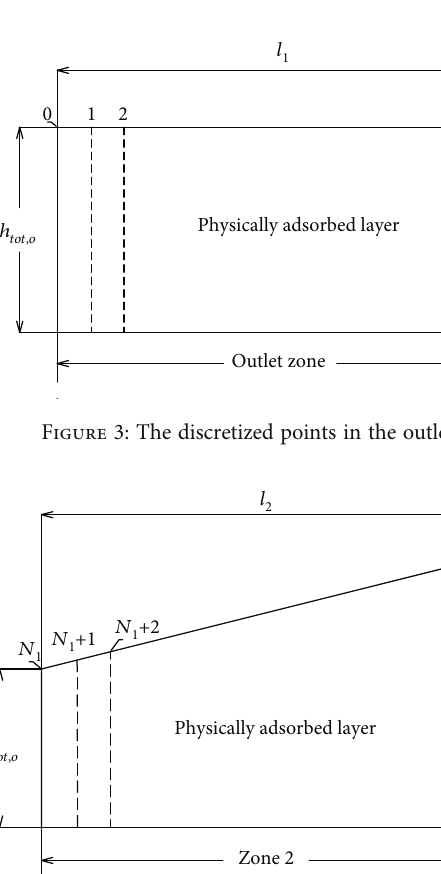
N N Þ discretized points in the bearing. 1 + 2 + 3 + 1